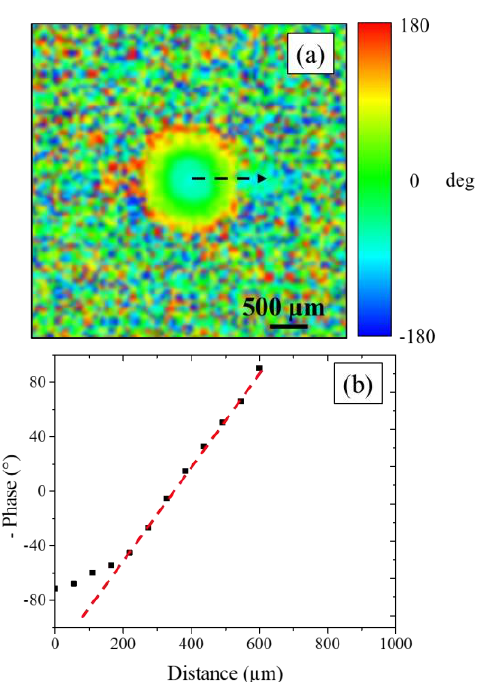
Fig. 6. (a) Phase-shift image and (b) the corresponding plot of the black dashed arrow of (a), scan at 800 Hz. The red dashed line in (b) is the linear fit used to calculate the thermal diffusivity of the